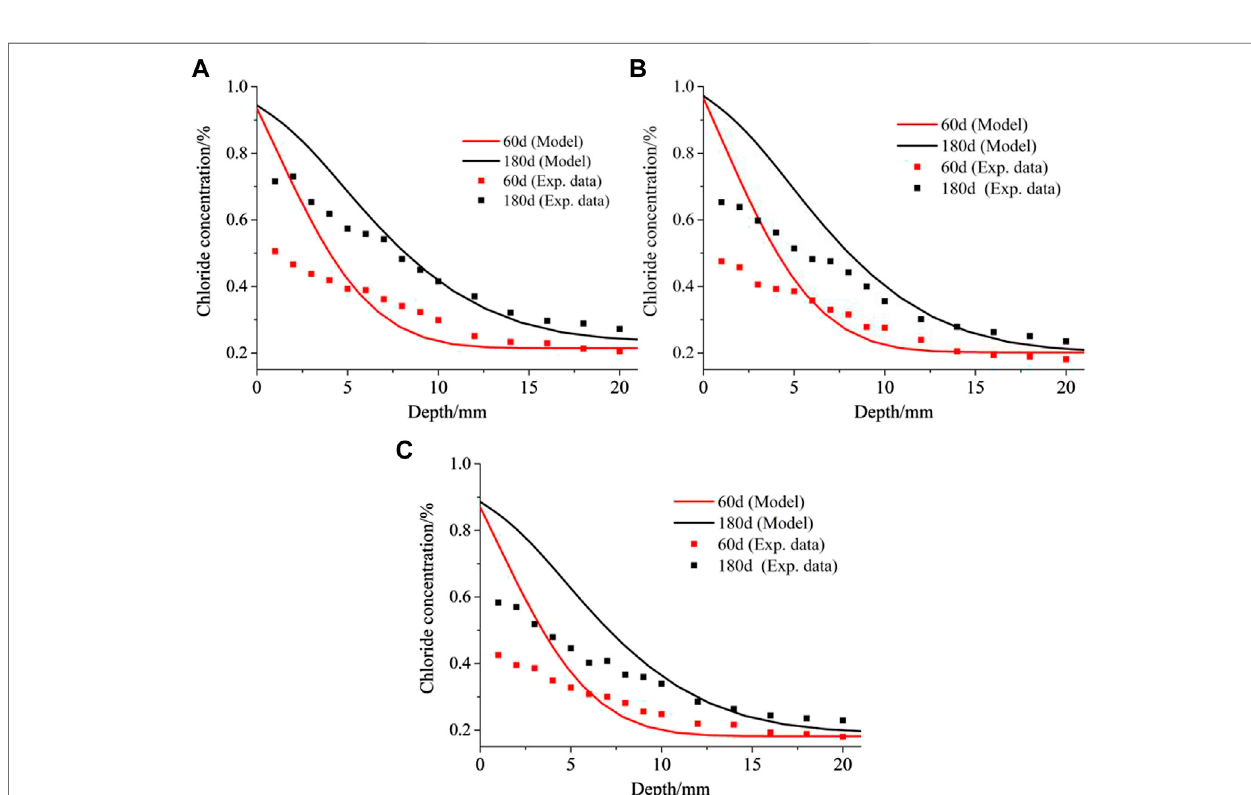
FIGURE 8 | Comparison between experimental and numerical results about free chloride concentration: (A) C25F15; (B) C30F15; (C) C40F15. Note that all the experimental data in the fi gure are from Huang et al. (2020a).